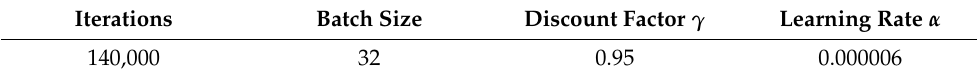
Table 4. Training parameters.